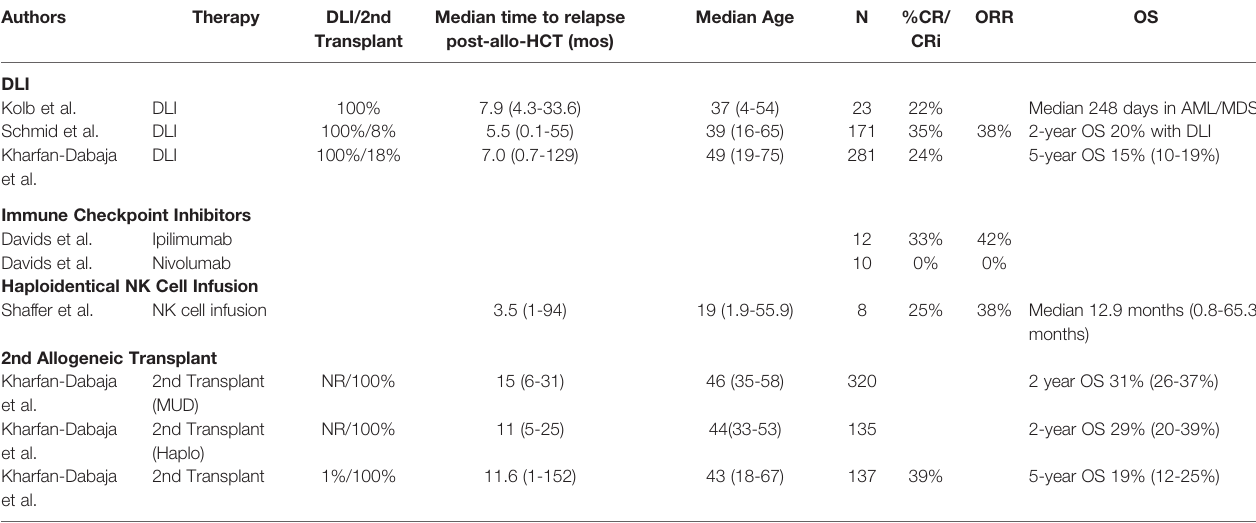
TABLE 4 | Studies using Immunotherapies for Post-Allo-HCT Relapse.